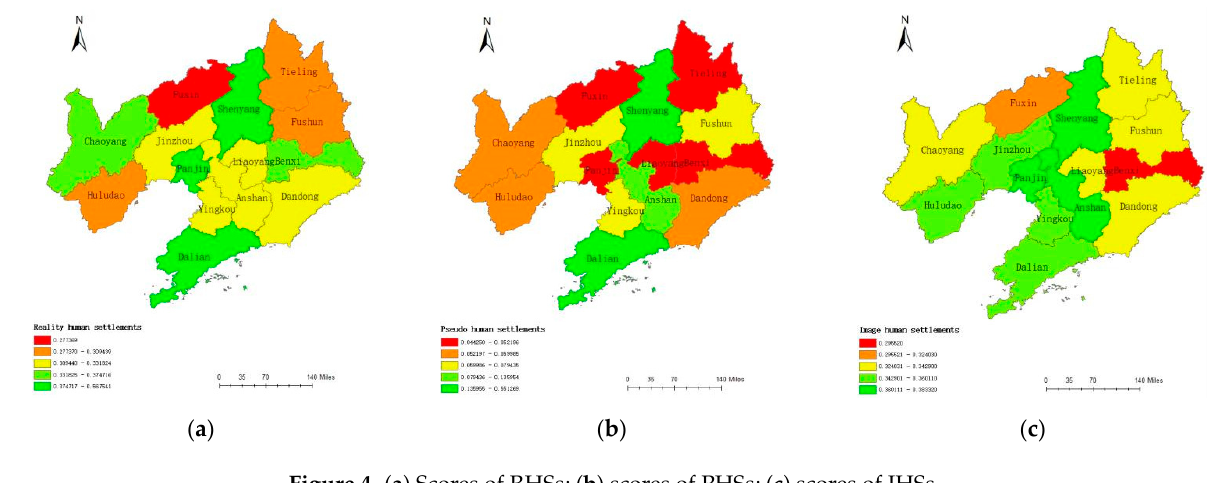
Figure 4. ( a ) Scores of RHSs; ( b ) scores of PHSs; ( c ) scores of